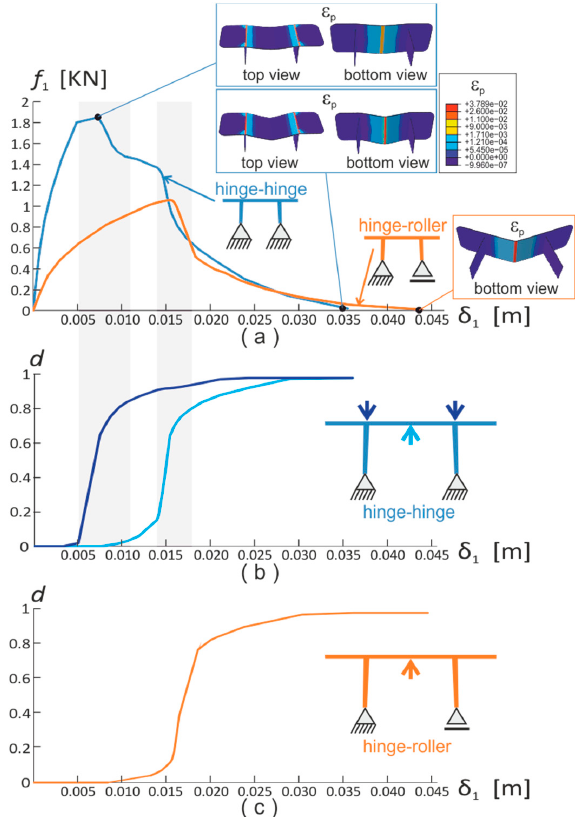
Figure 6. ( a ) Table geometry and loading conditions. ( b ) Boundary conditions.